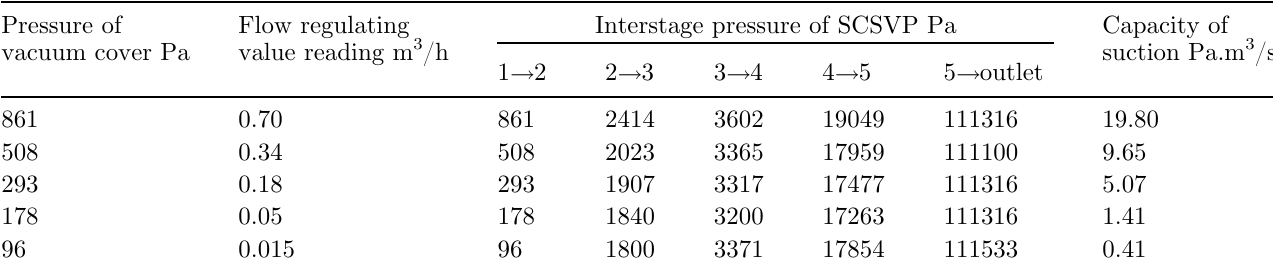
Table 2. Experimental